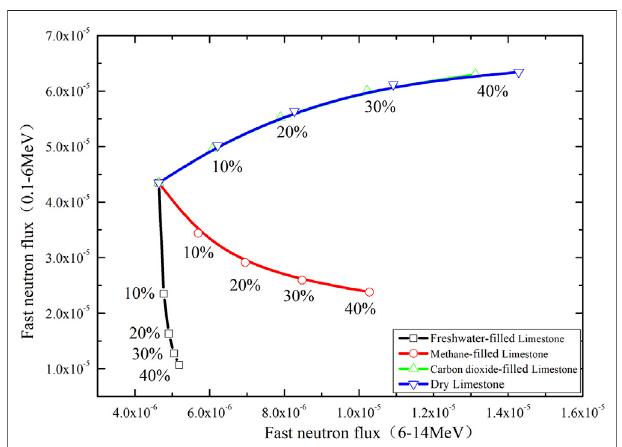
FIGURE 2 | Fast neutron fl ux distribution at different energy